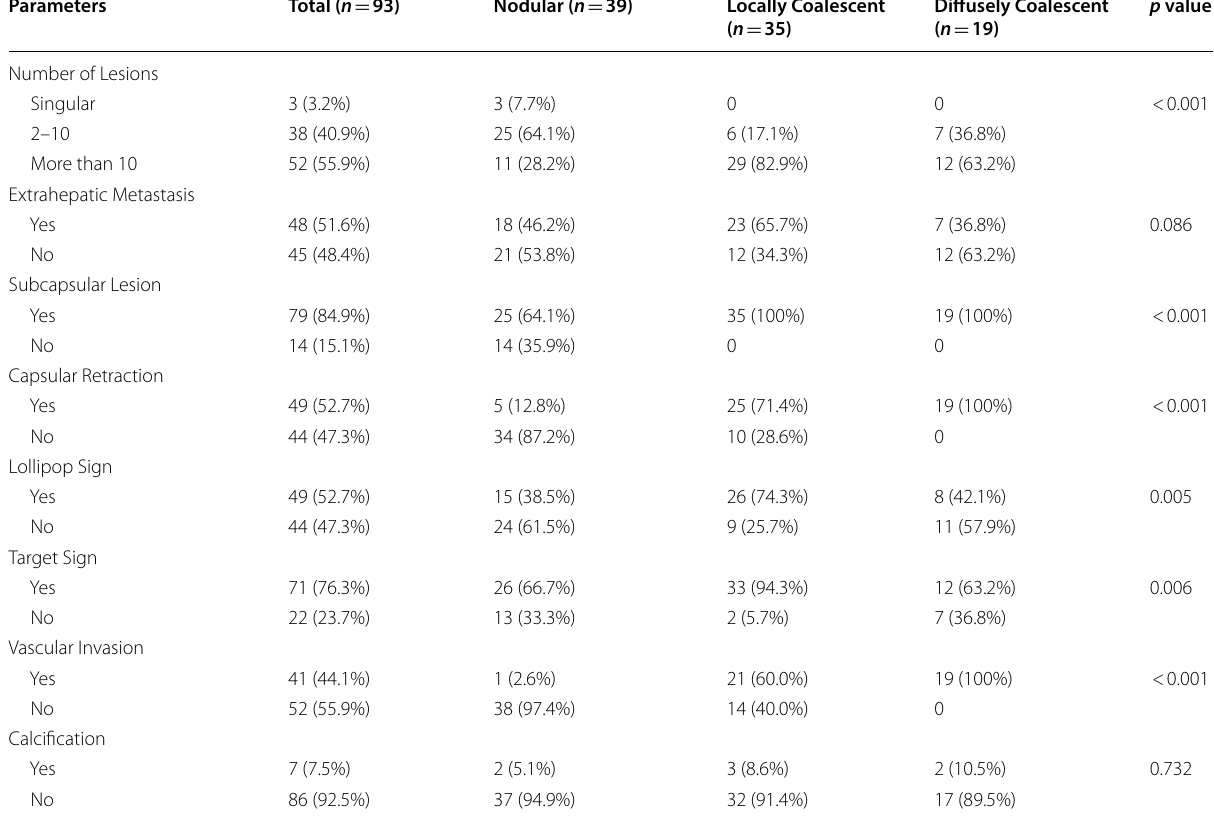
Table 3 Comparison of CT features among HEH patients with different lesion types Parameters Total ( n